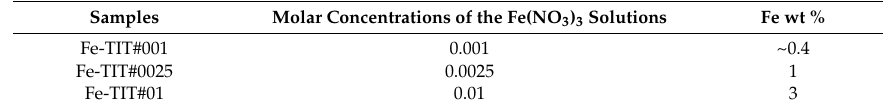
Table 1. Fe wt % of hydrogen titanate nanotubes after the ion-exchange with Fe(NO 3 ) 3 solutions. Samples Molar Concentrations of the Fe(NO 3 ) 3 Solutions